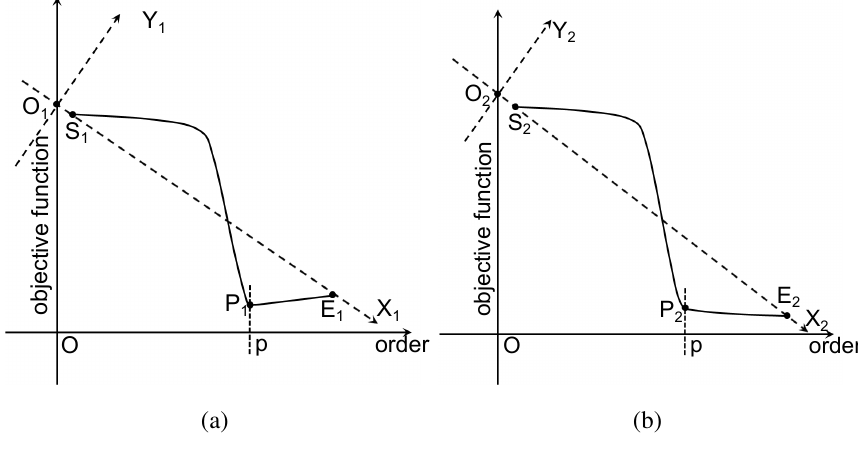
Figure 2. Geometric interpretation for adaptive Akaike information criterion (AAIC) and adaptive Bayesian information criterion (ABIC): the solid curves objective function values for AIC or BIC. The preferred orders are located at the point P and P , respectively. ( a ) The case that the criterion (AIC or BIC) successfully determines the 2 correct order, and ( b ) the case that the criterion fails due to the inadequate penalty strength. Under the new coordination system X the curve, and the correct order is